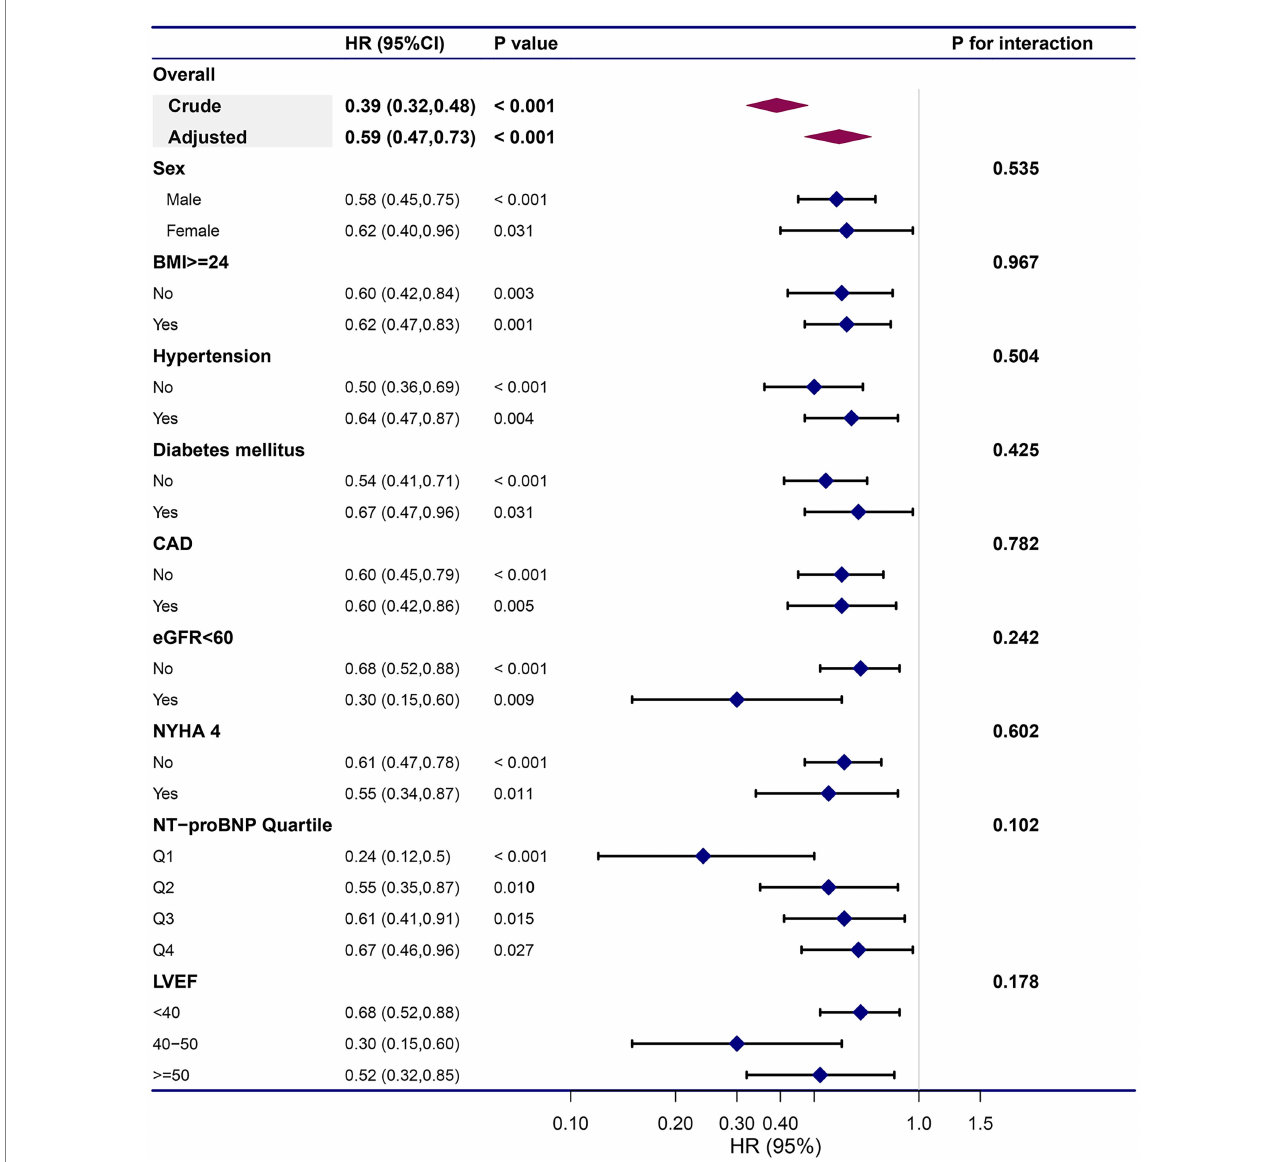
FIGURE 4 Subgroup analyses on prognostic role remnant cholesterol on all-cause mortality. The dots and lines indicate the estimates of the hazard ratio of all-cause mortality for per unit increment of remnant cholesterol with the corresponding 95% confidence intervals, respectively. The multivariate Cox regression model was adjusted for sex, age, body mass index, hypertension, diabetes mellitus, coronary heart disease, heart rate, systolic pressure, diastolic pressure, hemoglobin, albumin, alanine aminotransferase, aspartate transaminase, total bilirubin, serum uric, estimated glomerular filtration rate, high sensitivity C reactive protein, log(N-terminal pro-brain natriuretic peptide), left ventricular ejection fraction, New York Heart Association Functional Class and pharmacotherapy, except for the variable that is